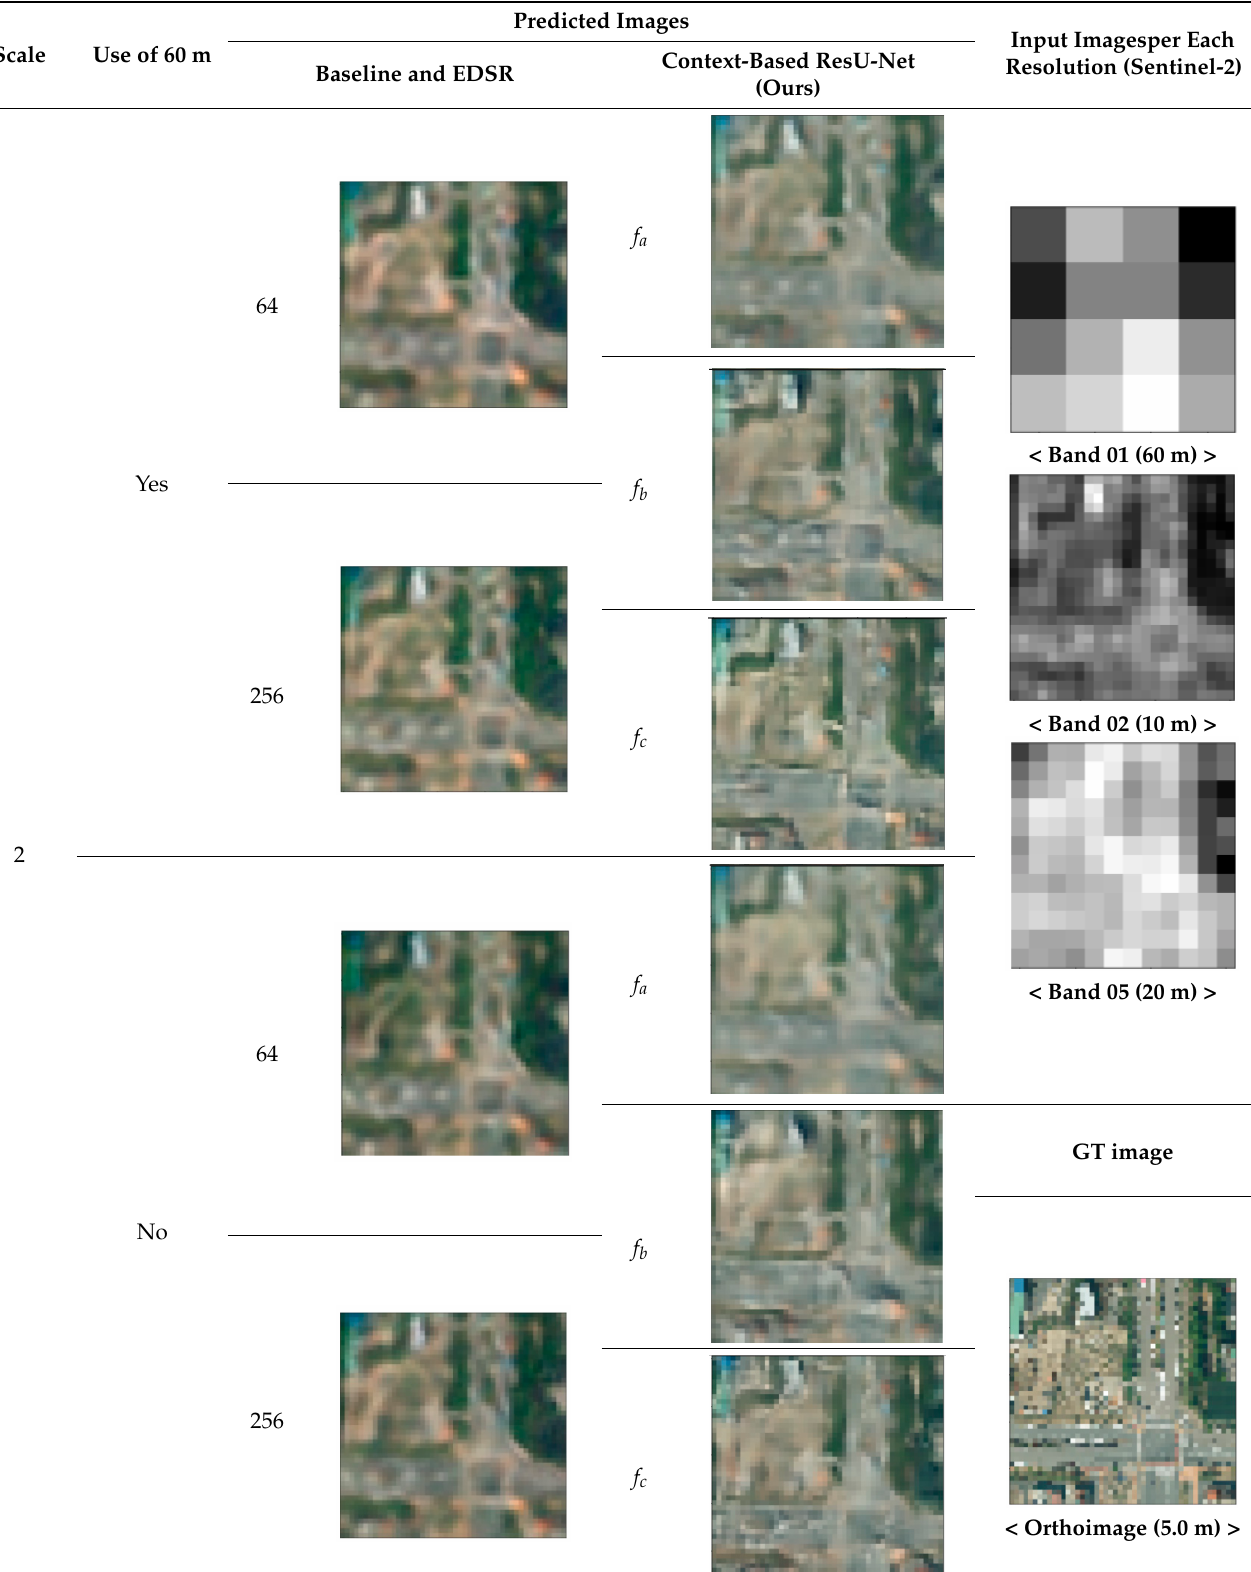
Table 9. Predicted images of Sentinel-2 and corresponding GT image (urban/road